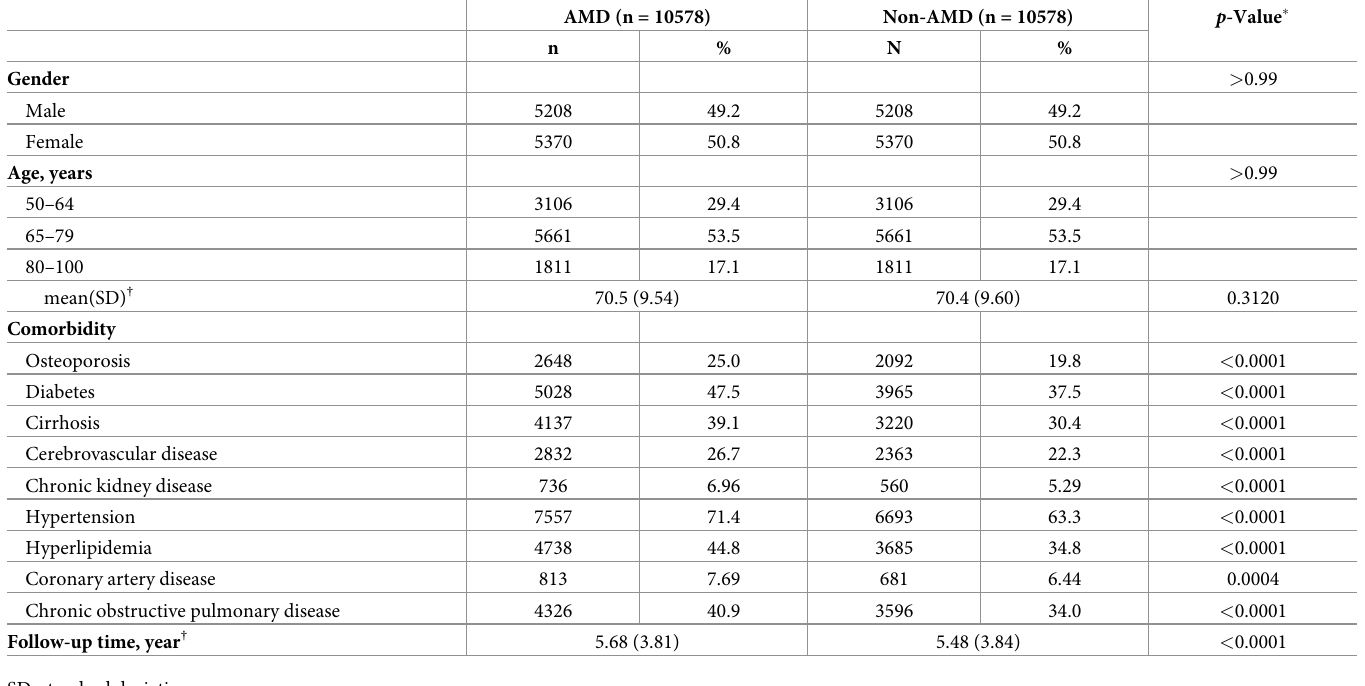
Table 1. Demographic characteristics and presence of comorbidities in patients with and without age-related macular degeneration (AMD). AMD (n =